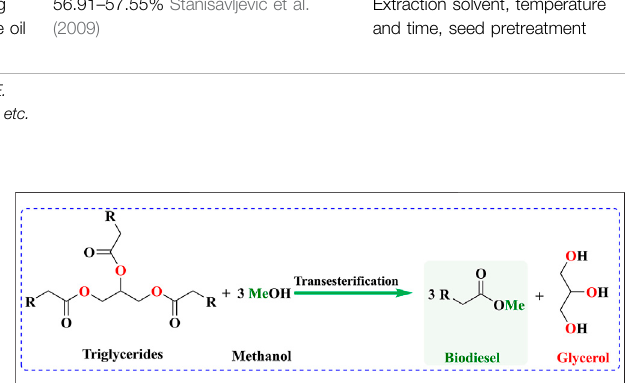
FIGURE 2 | General chemical reaction for the transesteri fi cation of